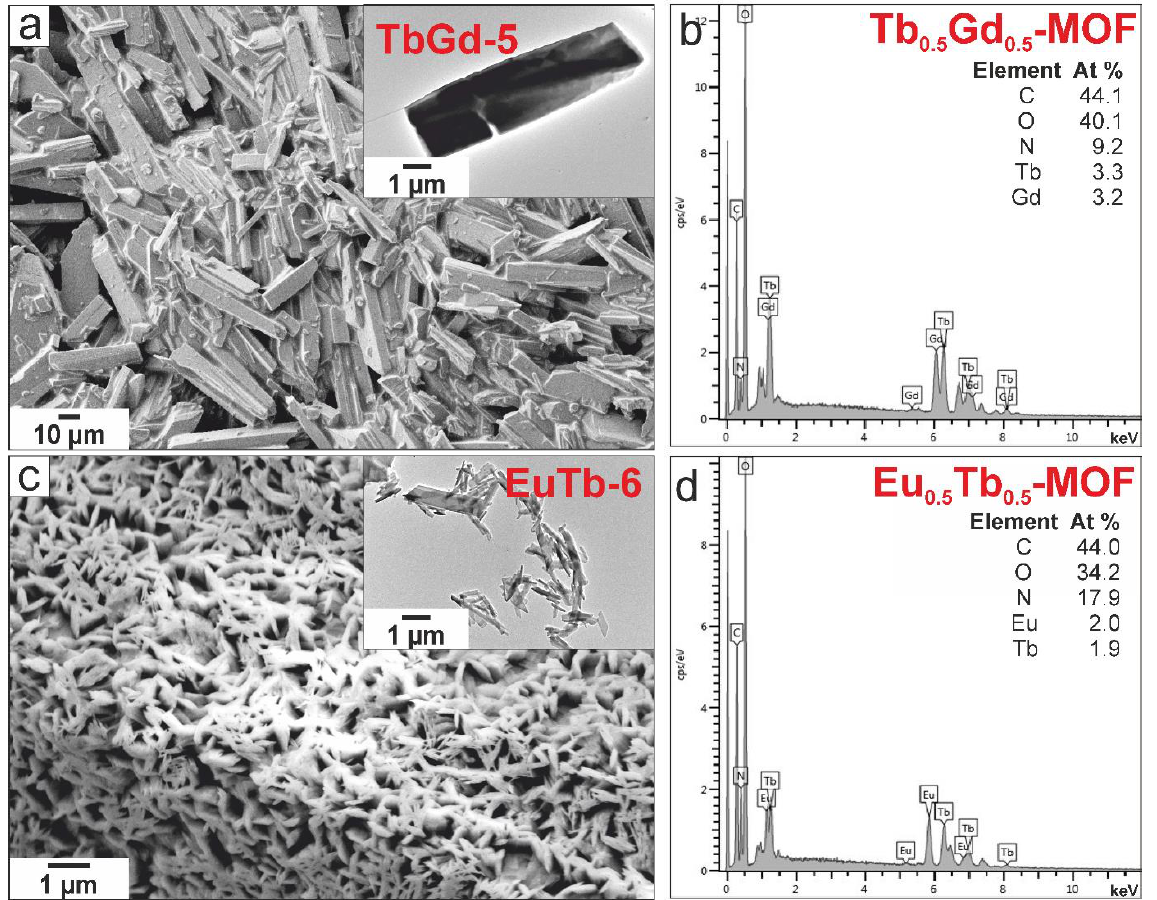
Figure 4. SEM morphology and TEM images (in insert) of LnMOF powders prepared by the solvothermal synthesis of ( a ) TbGd-5 (DMF/H 2 O) and ( c ) EuTb-6 (DMF/H 2 O/NaOAc); and the EDS spectra of ( b ) [Tb 0.5 Gd 0.5 (btc)] and ( d ) [Eu 0.5 Tb 0.5 (btc)].